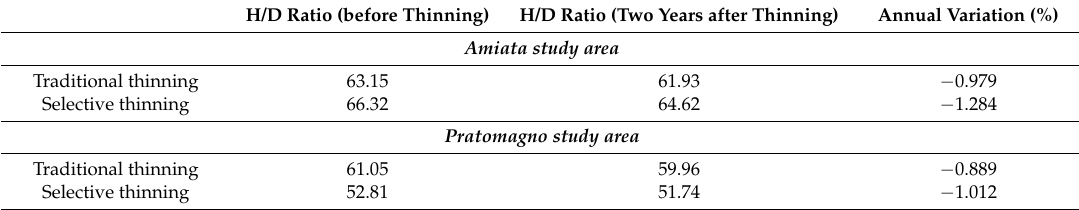
Table 2. H/D ratios before and after thinning in the two study areas.